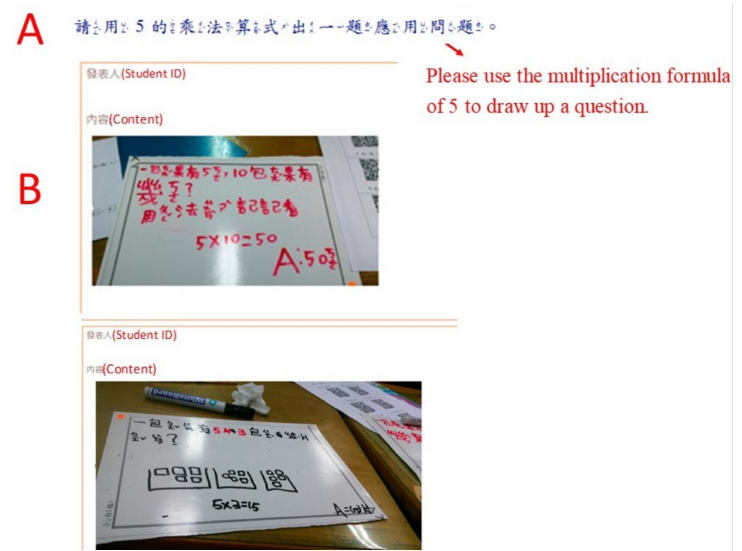
Figure 4. Students upload photos to participate in online discussion in the MLS. ( A ) The discussion topics in the online forum. ( B ) Students took photos of what they had written on the whiteboard and uploaded them to the online forum to participate in the